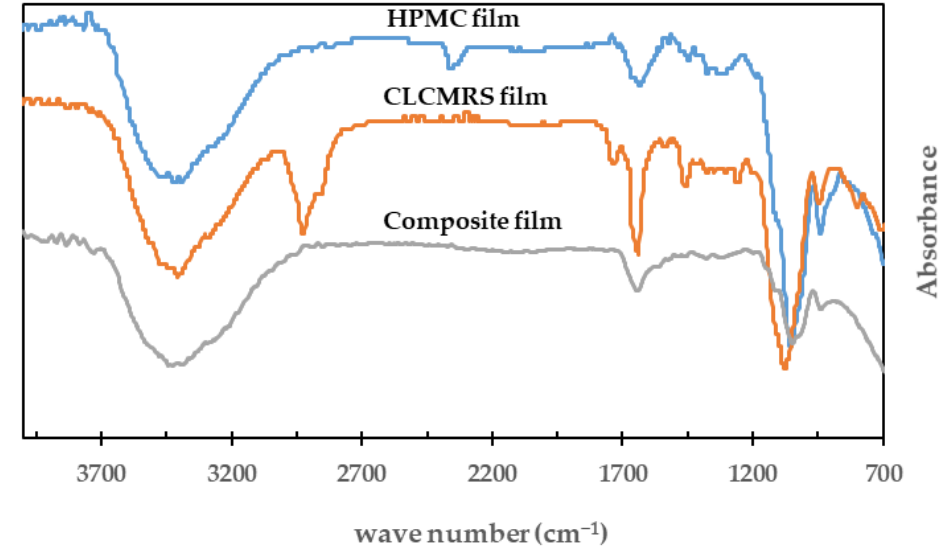
Figure 4. FTIR of HPMC, CLCMRS, and HPMC-CLCMRS composite films.